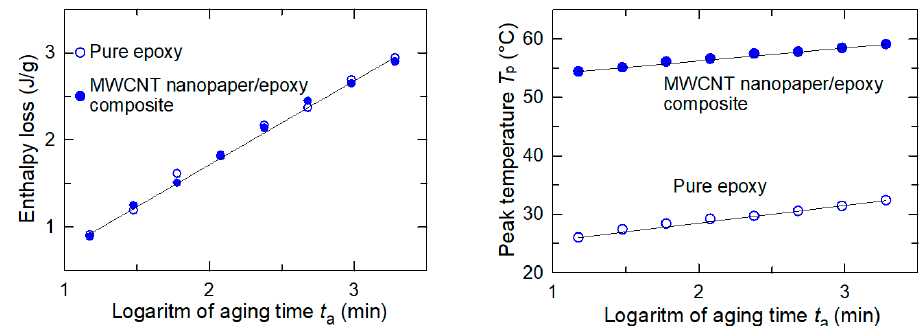
Figure 11. The enthalpy loss and the peak temperature T p dependence on aging time.